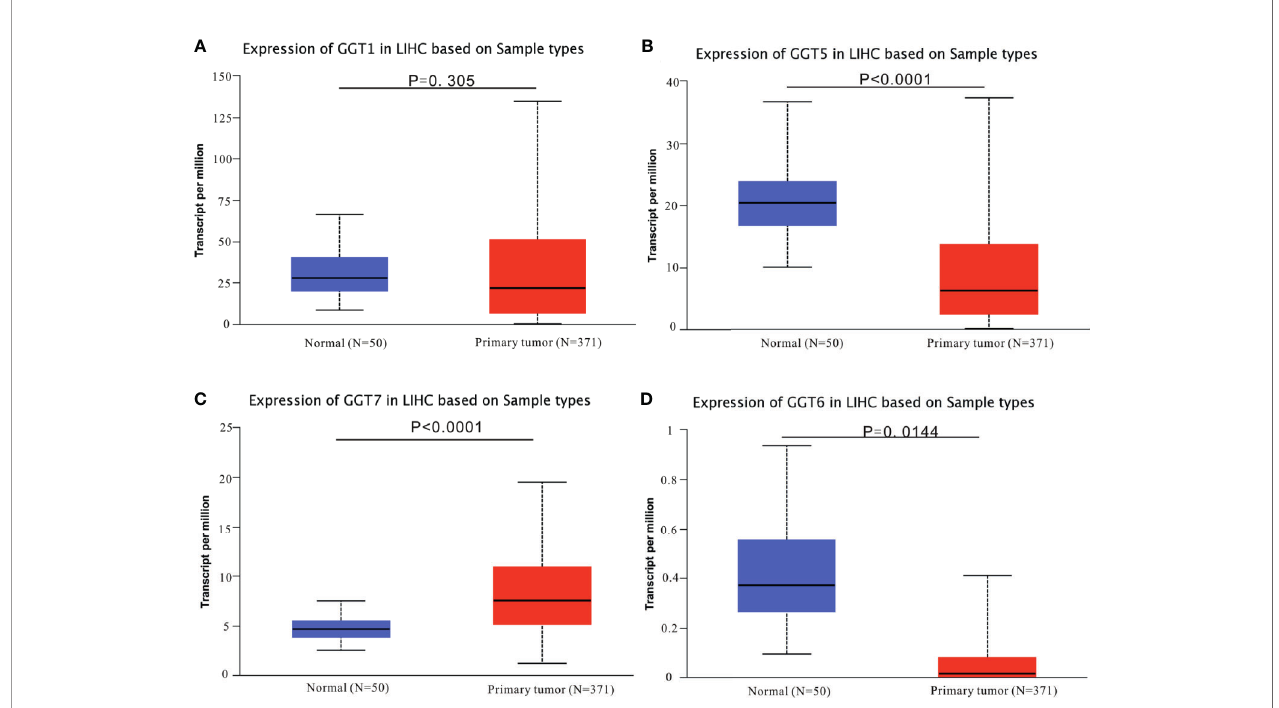
FIGURE 1 | Expression pro fi les of GGT family genes in HCC specimens and normal tissues from TCGA-LIHC dataset. (A) GGT1 ; (B) GGT5 ; (C) GGT6 ; (D) GGT7